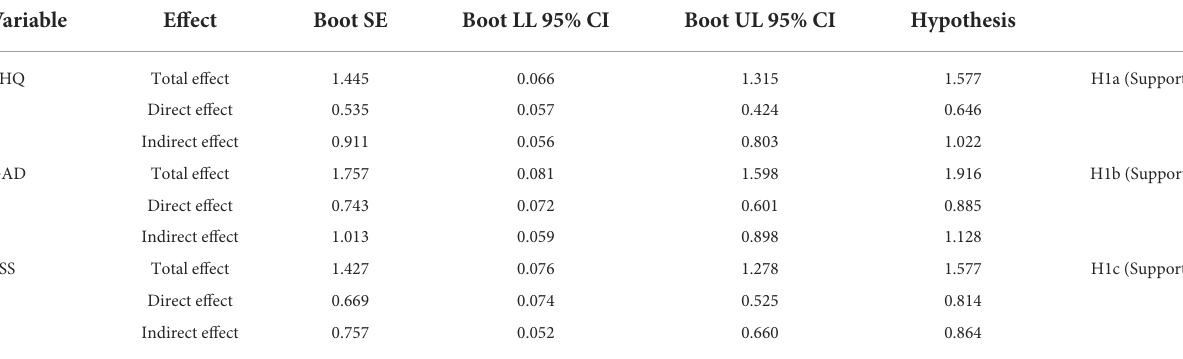
TABLE 5 Psychological resilience as a mediator in the relationship between COVID-19 related stressors and mental health.